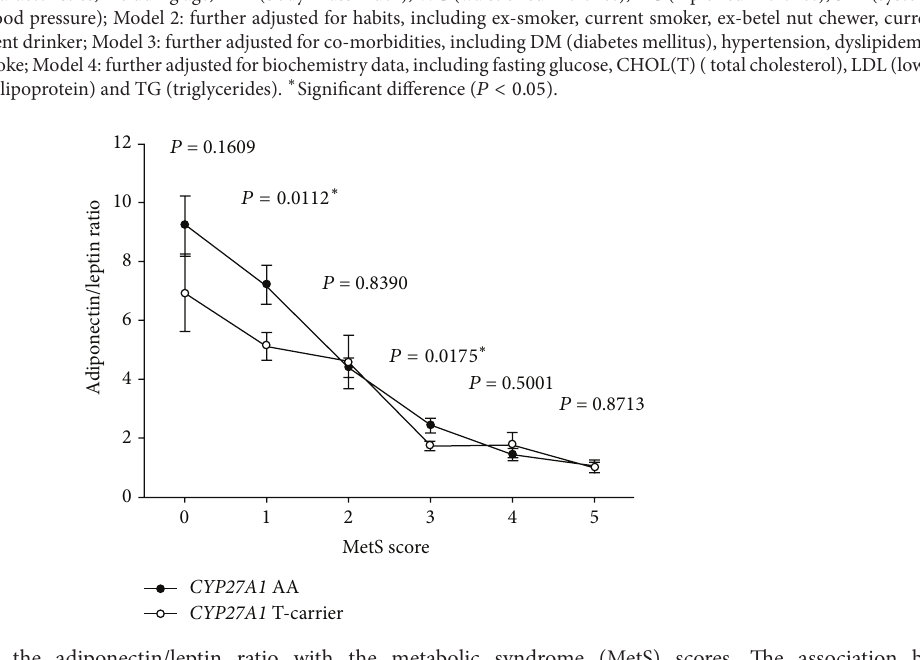
Figure 2: Associations of the adiponectin/leptin ratio with the metabolic syndrome (MetS) scores. The association between adiponectin/leptin ratio and the CYP27A1 rs4674344 SNP was more significant in the group with low MetS score than in the group with high MetS